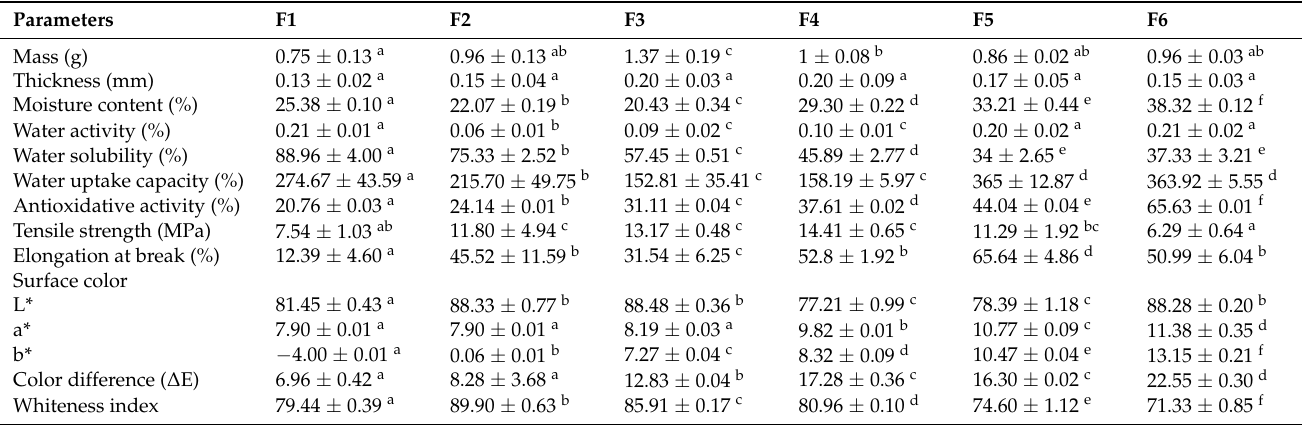
Table 2. Physico-mechanical and antioxidative properties of the biocomposite films 1